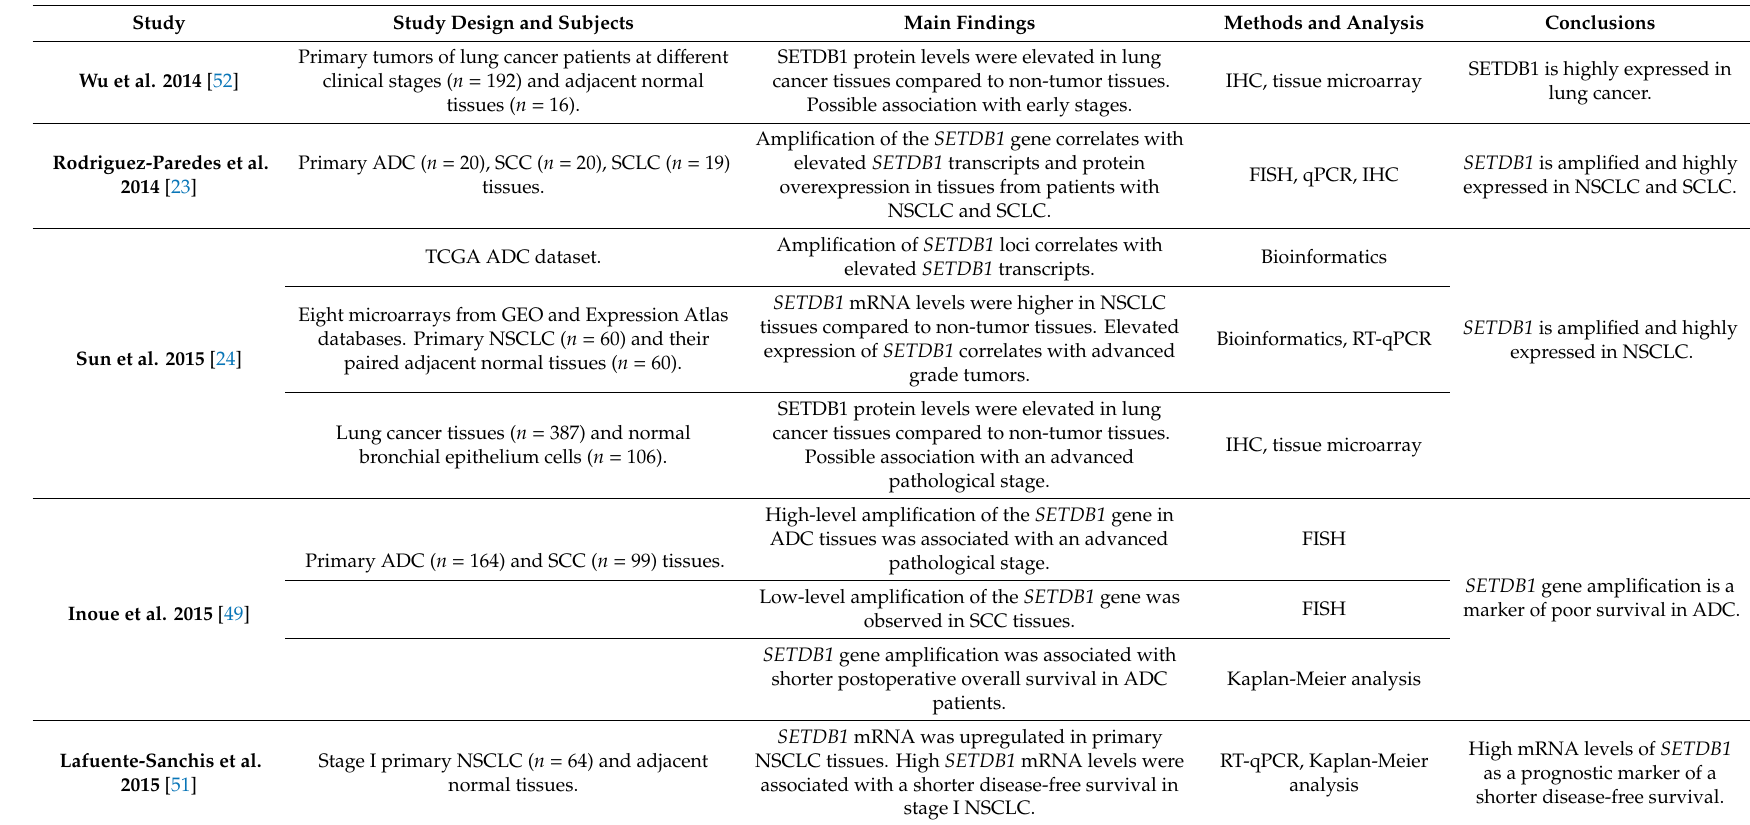
Table 3. Literature review on SETDB1 status in primary lung cancer